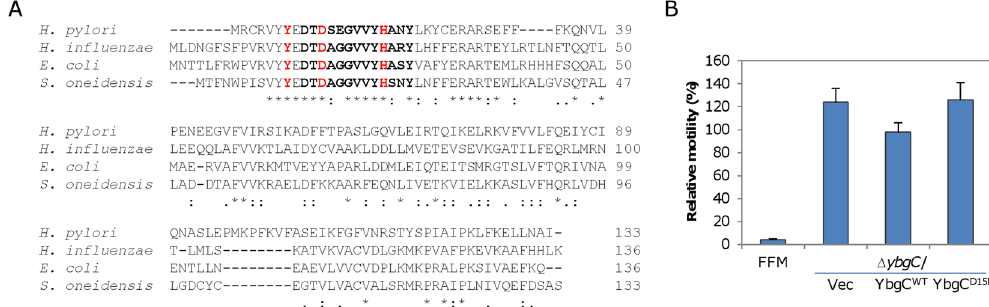
Figure 4. Thioesterase activity is required for the role of SoYbgC in motility. ( A ) Sequence alignment of So YbgC with YbgC proteins from E. coli , H. influenzae , and H. pylori , whose thioesterase activity has been confirmed. The consensus sequence for the active site core of thioesterase is in bold. Three residues that are essential to thioesterase activity are in red, of which Asp15 is subjected to mutation to create mutants deficient in thioesterase activity. ( B ) Effect of So YbgC D15N on motility. Expressed So YbgC D15N in the ∆ ybgC strain under P tac in the presence of 0.05 mM IPTG could not function as the wild-type with respect to motility. Vec and YbgC WT represent the empty plasmid and the vector carrying the wild-type YbgC, respectively. The experiment was performed at least three times with SEM presented as error bars.